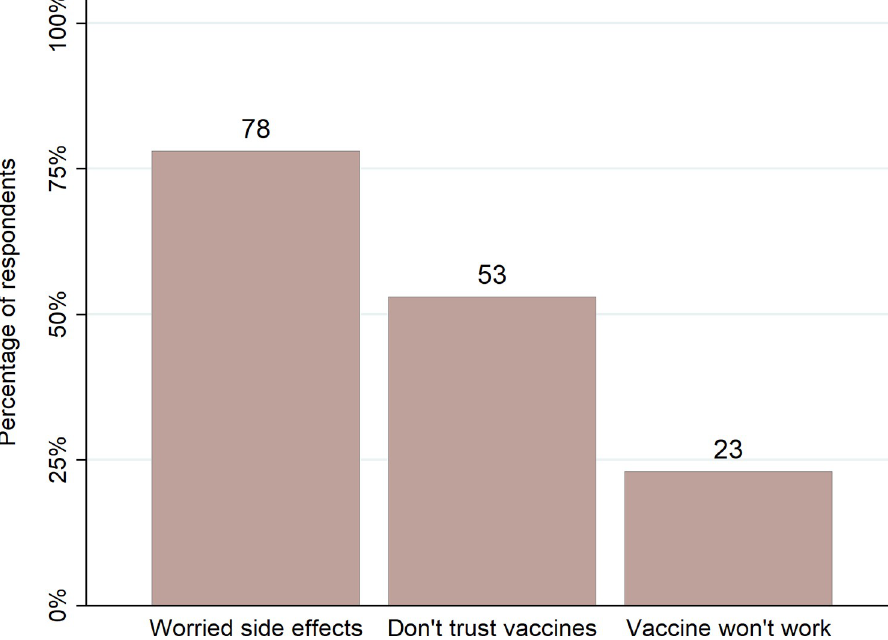
Fig 2. Top three reasons for vaccine hesitancy in PNG. Note: people could select more than one reason. As a result, responses total to more than